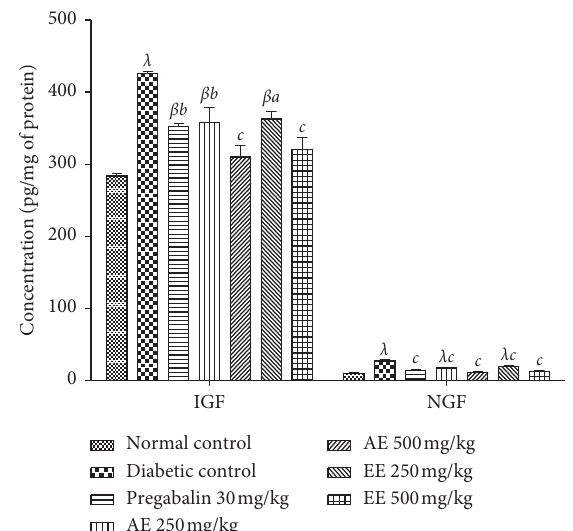
Figure 7: Effects of the aqueous (AE) and ethanol (EE) extracts of Dissotis thollonii on the levels of IGF and NGF in the sciatic nerve of diabetic mice. Values are expressed as mean ± SEM for six animals and analyzed by one-way ANOVA followed by the Tukey post hoc test. β p < 0 . 01, λ p < 0 . 001 when compared with the normal control and a p < 0 . 05, b p < 0 . 01, c p < 0 . 001 when compared with the diabetic control.